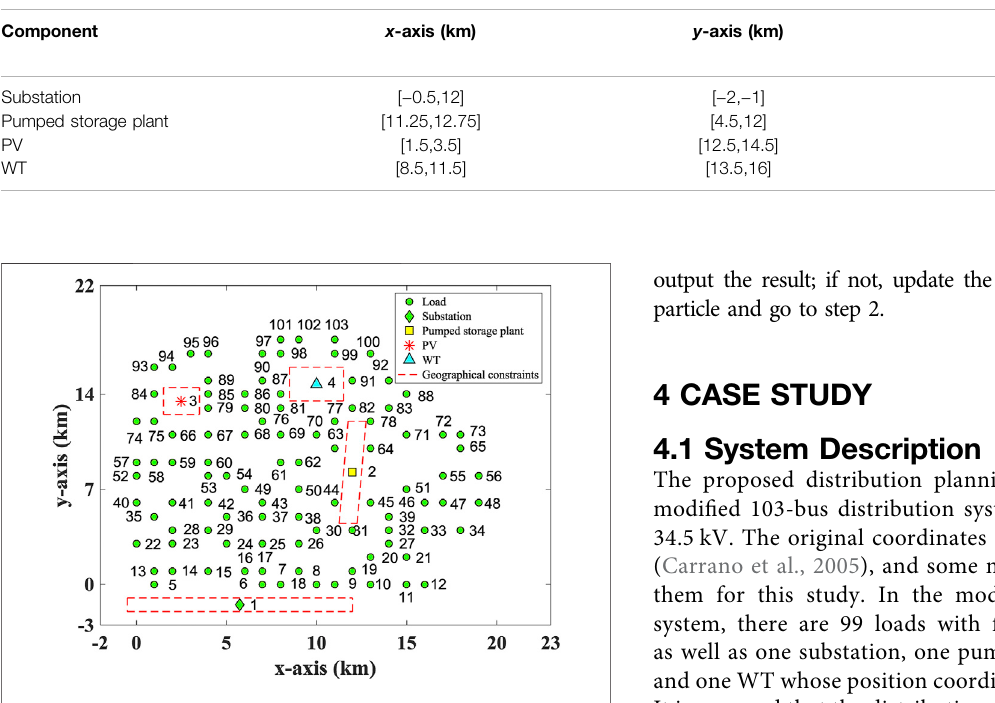
FIGURE 4 | 103-bus distribution network under study.